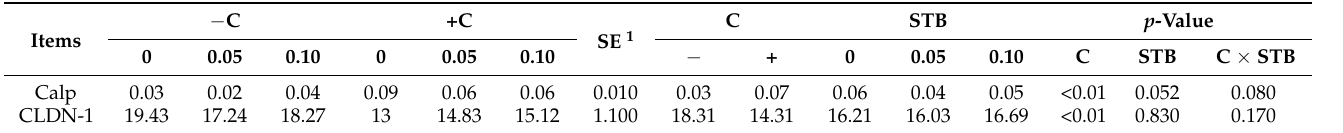
Table 8. Effects of stimbiotic supplementation on the expression of tight junction proteins of pigs challenged with STEC.